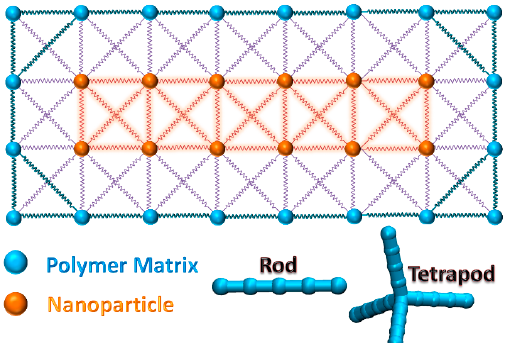
Figure 1. The interconnectivity of the 3D lattice spring model in a typical layer which depicts the branched rod incorporated in a polymer matrix, nearest [100] and next nearest [110] neighbor spring interactions are considered. Three kinds of springs are represented by different colors (different spring constants). The schematic diagrams of rod and tetrapod with aspect ratio of 5 are shown in the right bottom corner.